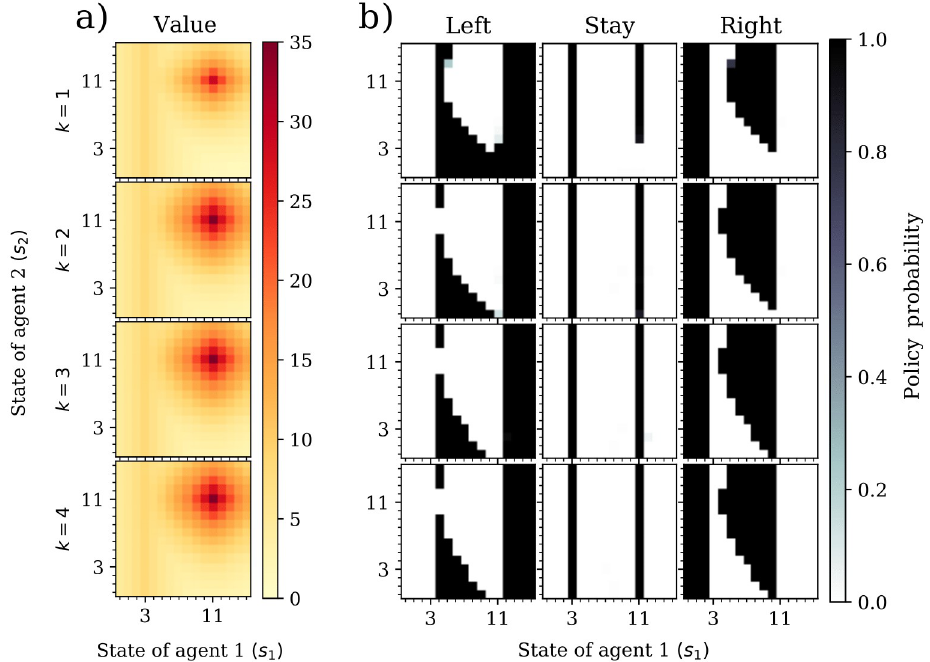
Fig 6. Effect of sophistication in value and policies in the Markov stag hunt game. (a) CPT values of the agent states, for sophistication levels k = 1, 2, 3 and 4. Joint states with redder colors have higher value. (b) Policies for sophistication levels k = 1, 2, 3 and 4. Joint states with darker color indicate higher probability. The value of the stag state grows with the sophistication level. We assumed reference points b 1 = b 2 = 0, discount factors β 1 = β 2 = 0.9, utility function u ( x ) = x and probability weighting w ð x Þ ¼ e (cid:0) 0 : 5 ð(cid:0) log ð x ÞÞ 0 : 9 .